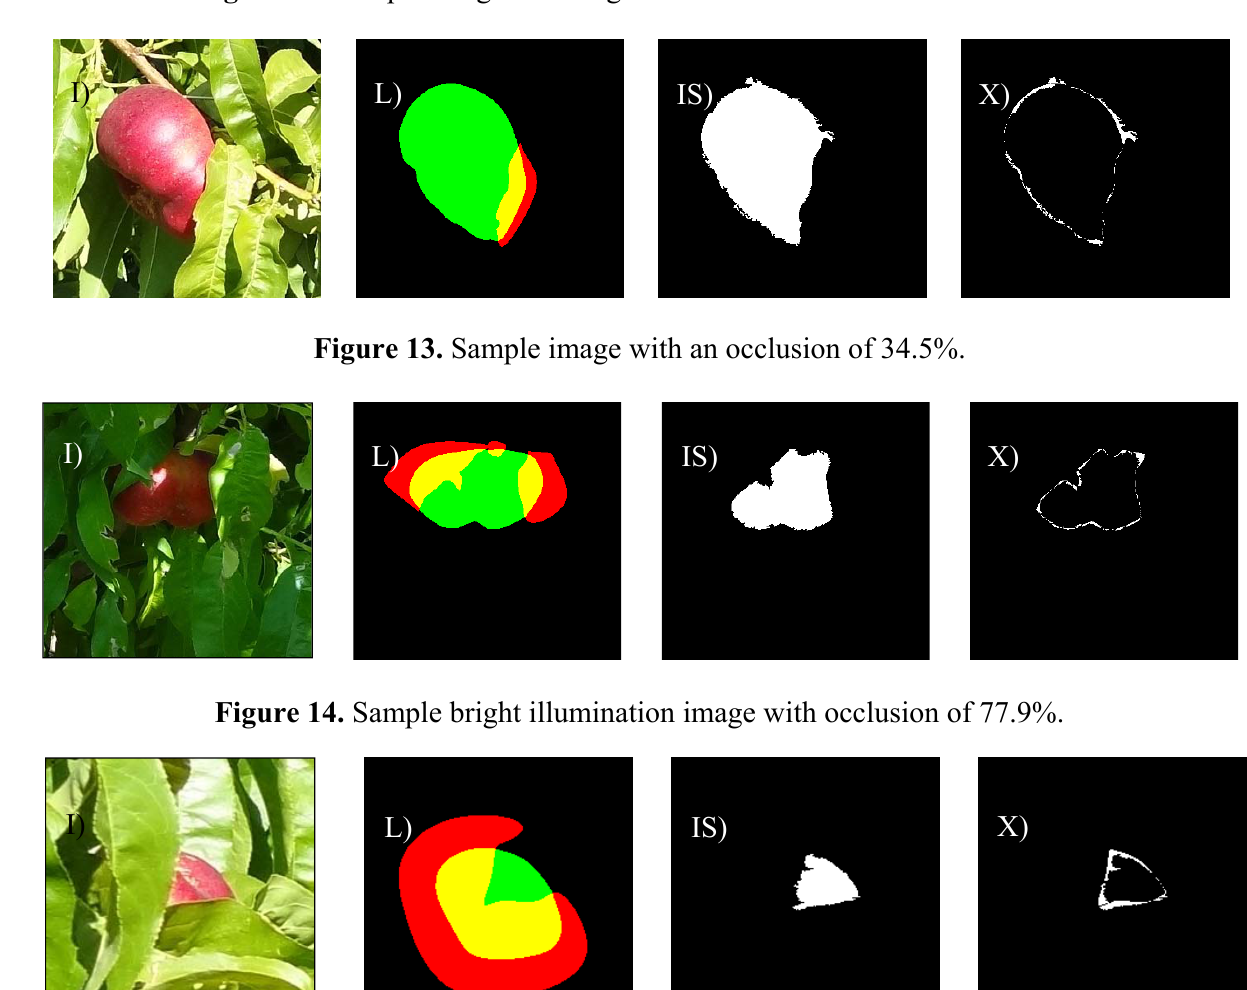
Figure 12. Sample image with bright illumination and occlusion of 9.5%.